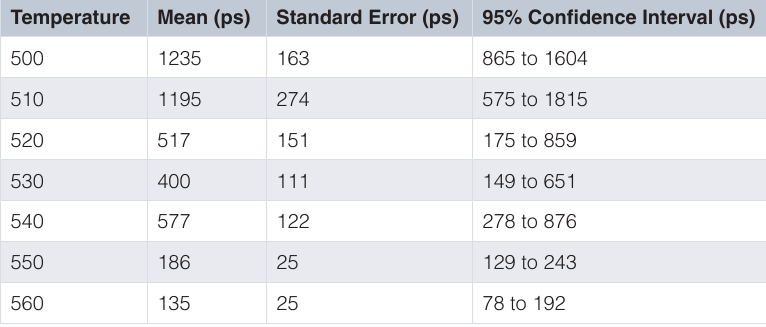
Table 2. Times for loss of the beta sheet from the protein in picoseconds.